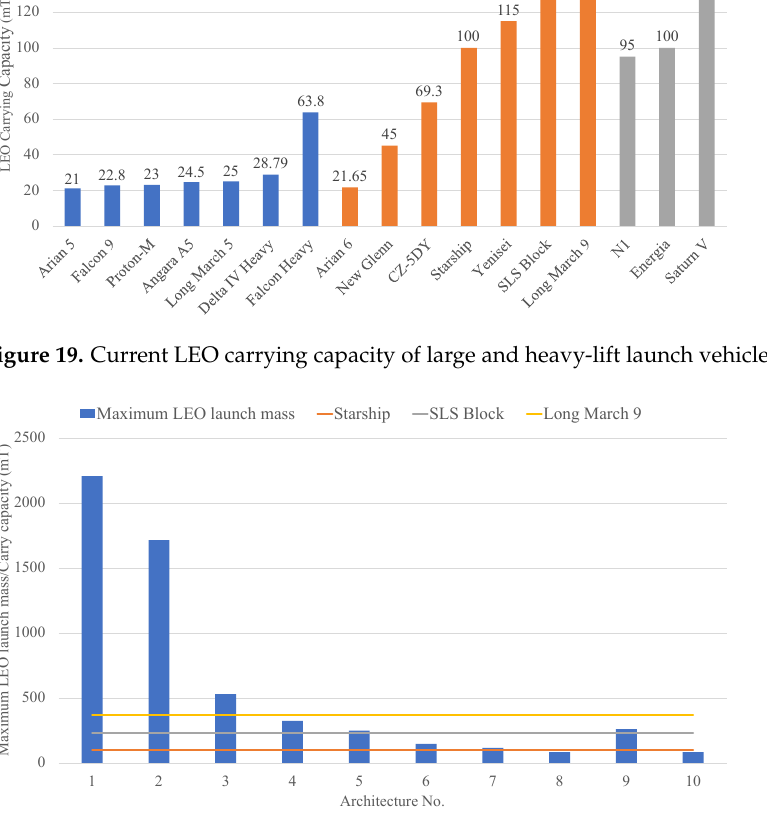
Figure 20. Comparison of the maximum LEO launch mass of 10 architectures with the LEO carrying capacity of selected launch